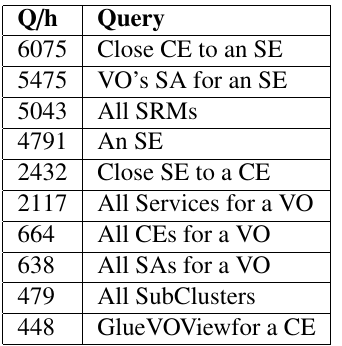
Table 2. Top ten queries from 2019. GLUE 2.0 queries in